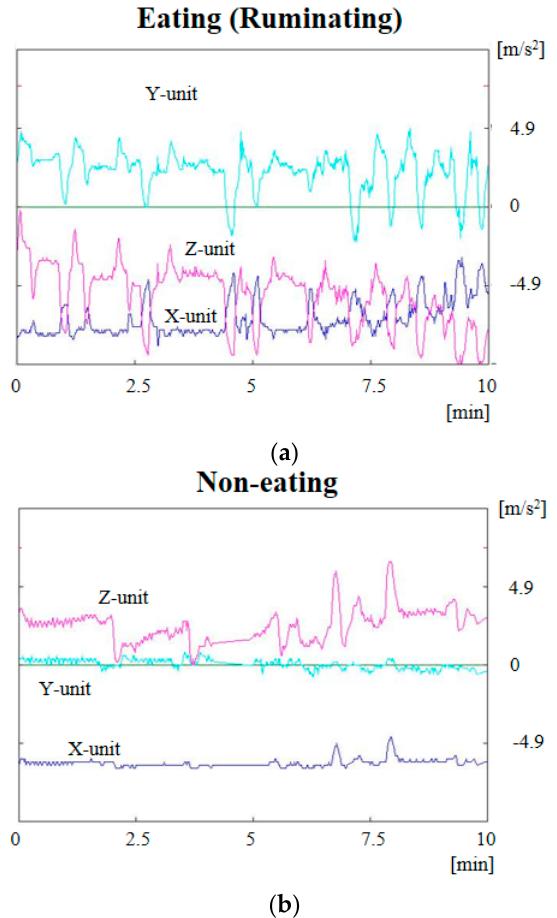
Figure 6. Measurement results of the change of acceleration data for x-axis, y-axis and z-axis within 10 min when the cow is eating (ruminating) ( a ) and when the cow is non-eating ( b ).